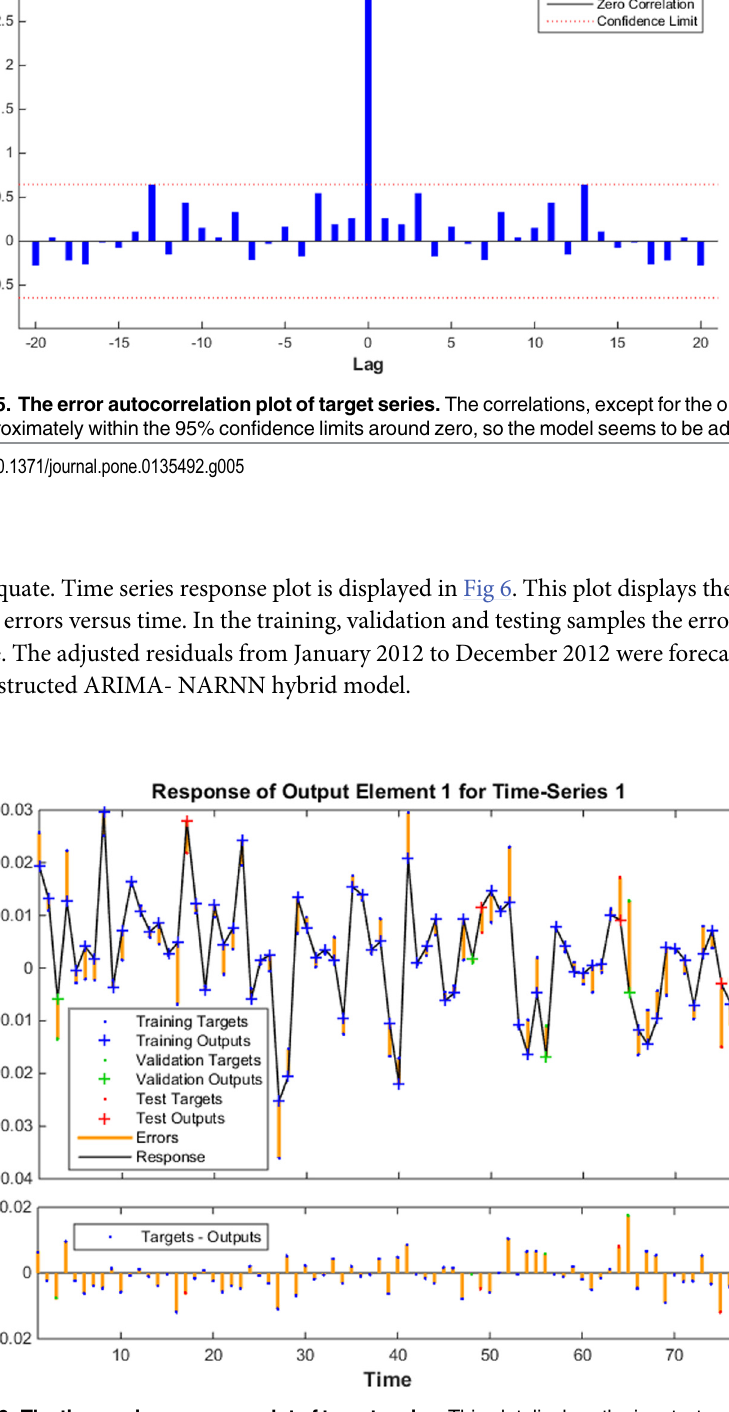
Fig 6. The time series response plot of target series. This plot displays the inputs, targets and errors versus time. In the training, validation and testing samples the errors were small. We assured that the model was